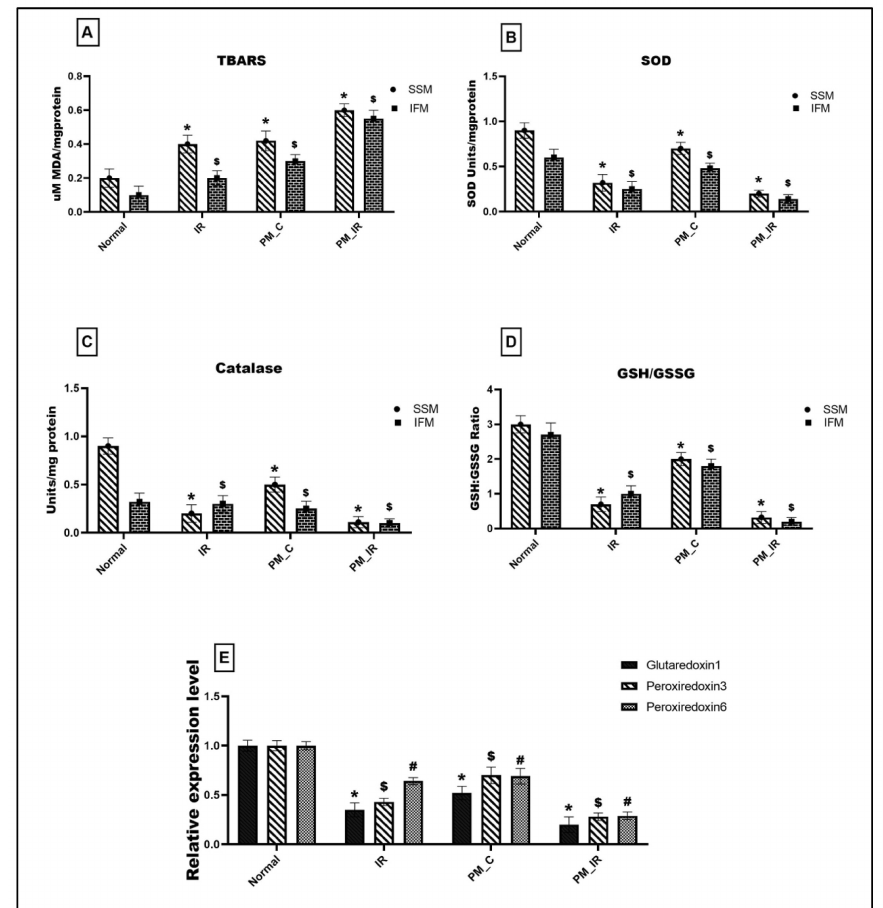
Figure 5. Assessment of mitochondrial oxidative stress. ( A ) Lipid peroxidation: TBARS level, ( B ) SOD, ( C ) catalase, ( D ) GSH:GSSG ratio, (* p < 0.05 vs. normal of SSM, $ p < 0.05 vs. normal of IFM). ( E ) Gene level expression of glutaredoxin 1, peroxiredoxin 3, and peroxiredoxin 6 where * ,$,# p < 0.05 vs. Normal, where * corresponds to the normal of glutaredoxin 1, $ to the normal of peroxiredoxin 3, # to the normal of peroxiredoxin 6, respectively. Values are mean ± SD ( n = 6 per group). [Groups: (1) Normal, (2) IR, (3) PM_C, (4)